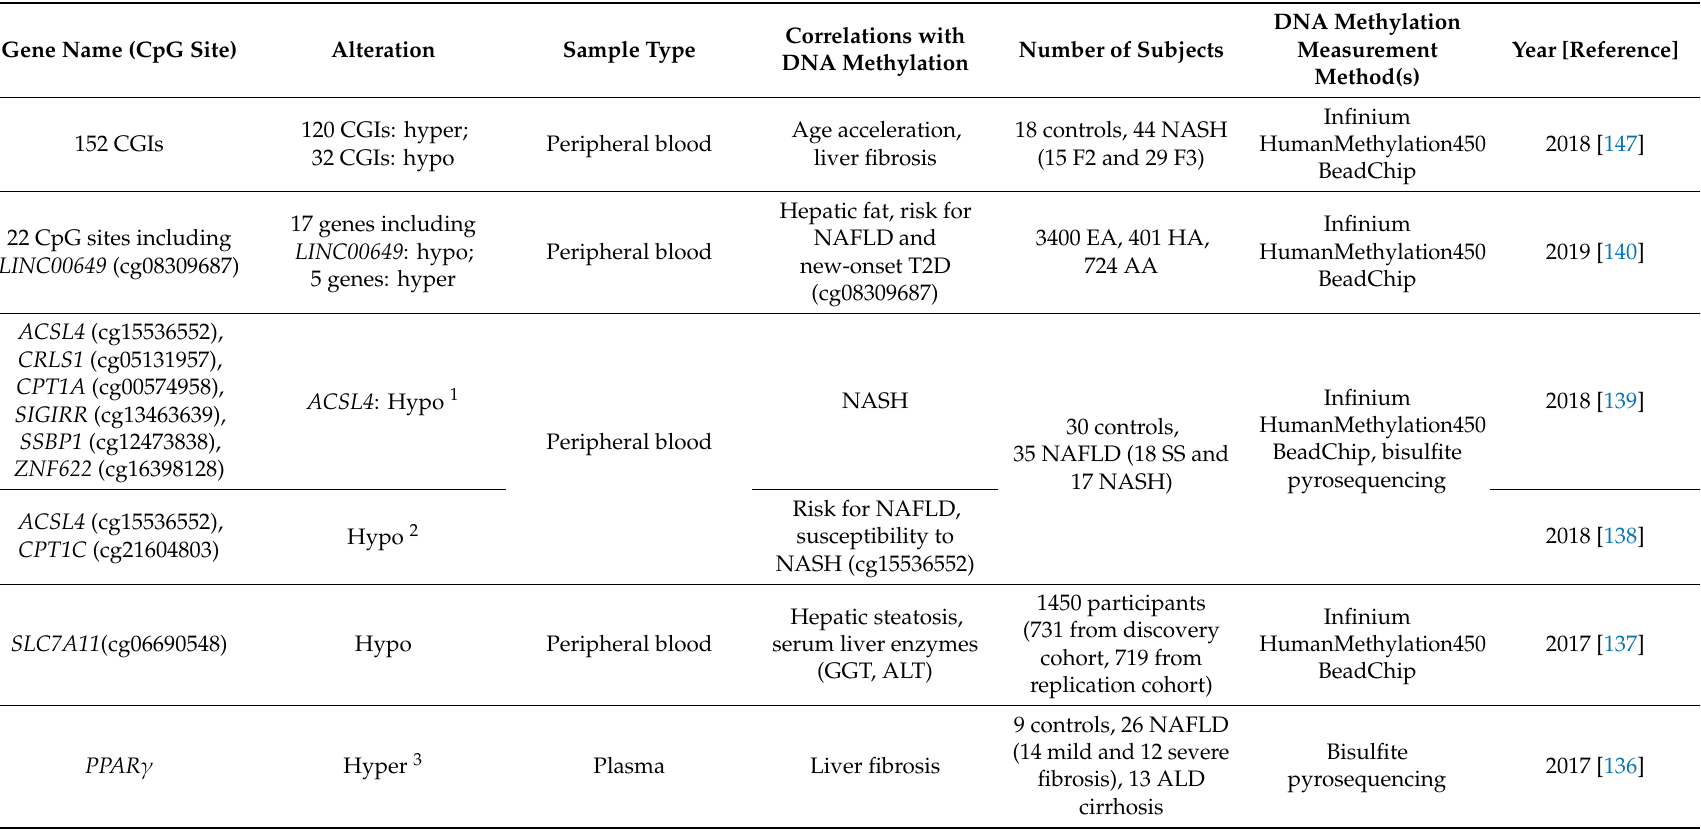
Table 2. Alteration of circulating DNA methylation in NAFLD